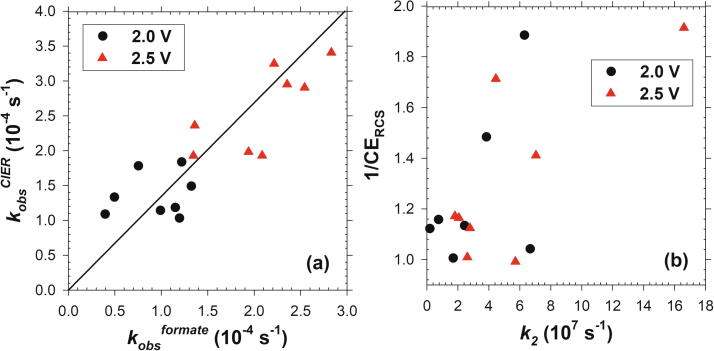
Correlations between (a) rate constants of ClER (kobsClER) and formate degradation (kobsformate), together with (b) current efficiency of reactive chlorine generation (CERCS) and transition rate constant (k2) from MOx(∙OH) to MOx+1.